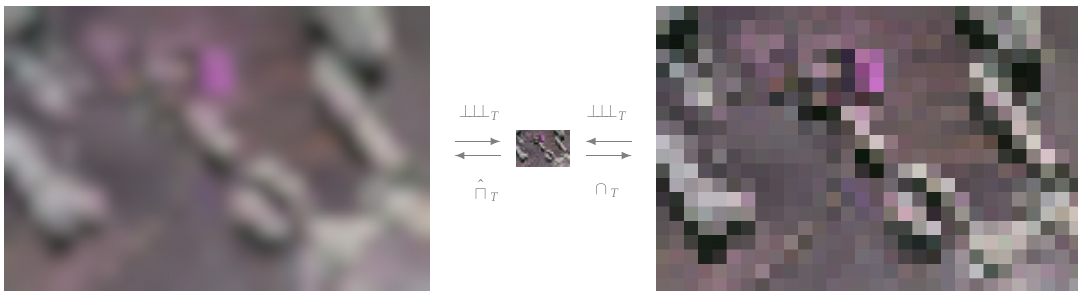
Figure A6. Radar image, scale T = [ 10,10 ] m, “Sinc”, “Dirac” and “Rect” shaped